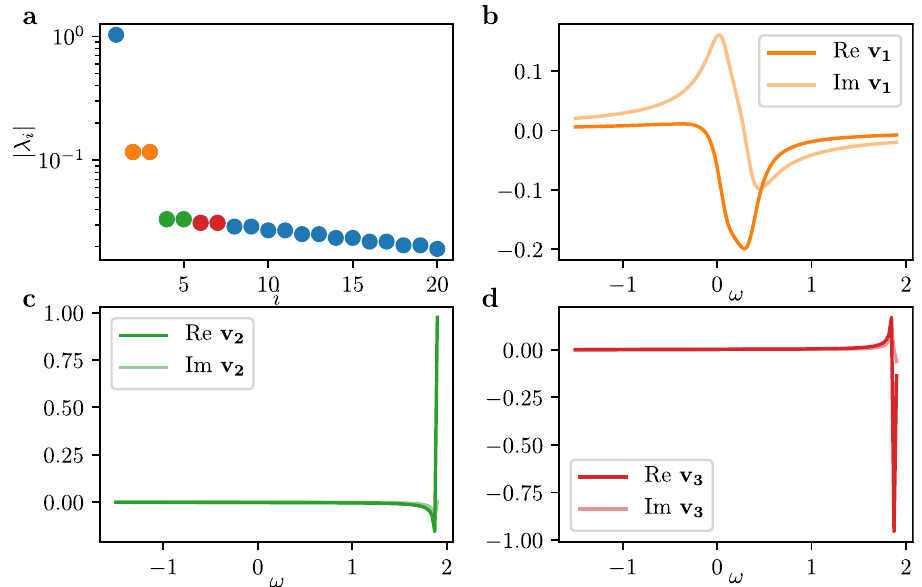
(cid:4) (cid:4) (cid:4) (cid:4) , obtained